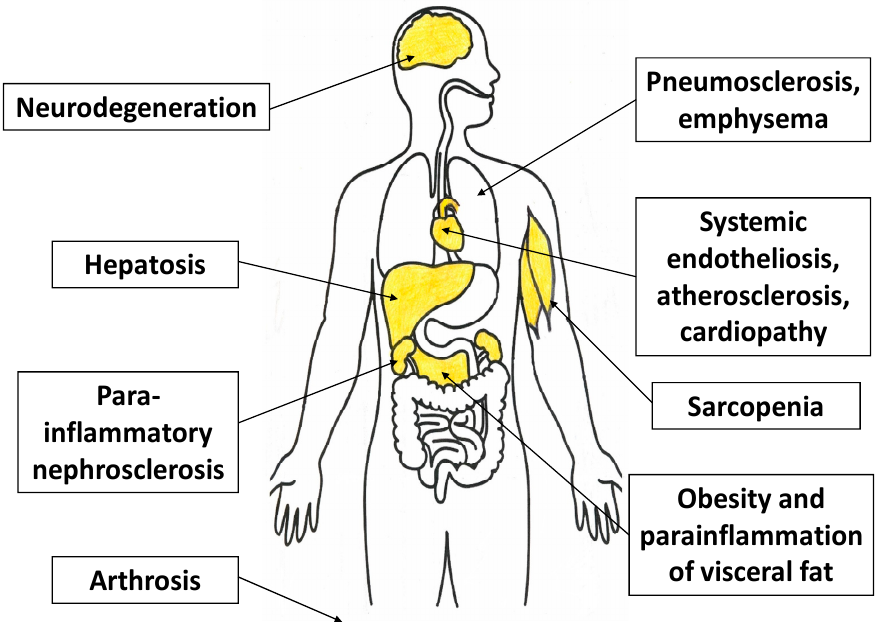
Figure 7. The main target organs in the development of chronic systemic low-grade inflammation.